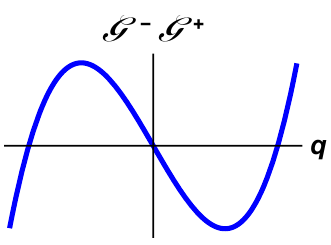
+ (cid:0) of the spin- 3 G G